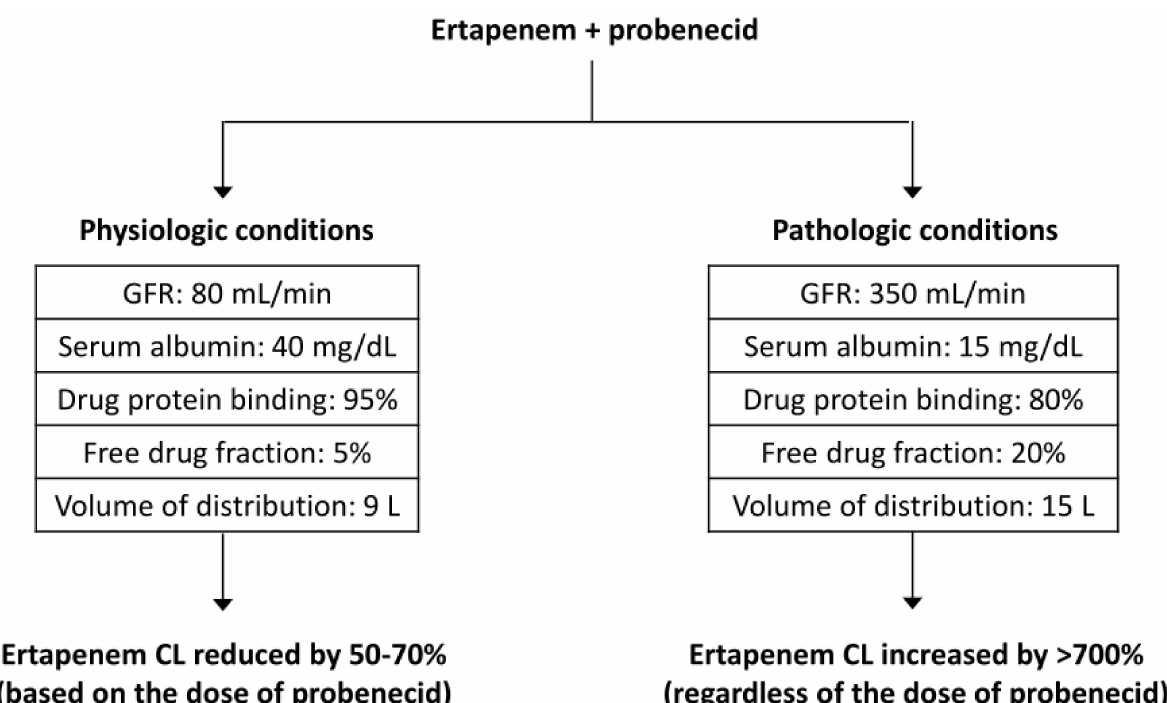
Figure 1. In physiologic conditions ( left side ), concomitant administration of probenecid resulted in a dose-dependent reduction (50–70%) in the clearance (CL) of ertapenem. In pathologic conditions ( right side ), the presence of a severe hypoalbuminemia resulted in a 400% increase in the ertapenem free fraction available for renal excretion. This effect was amplified by the presence of augmented renal clearance (400% increase in the glomerular filtration rate, GFR). Moreover, the patient also gained 6 L of fluids, further diluting the concentrations of ertapenem (the volume of distribution increased by 40%). The net result is a severe reduction in the CL of ertapenem related to the pathological conditions associated with ICU which greatly outweigh the effect of the pDDI related to concomitant probenecid